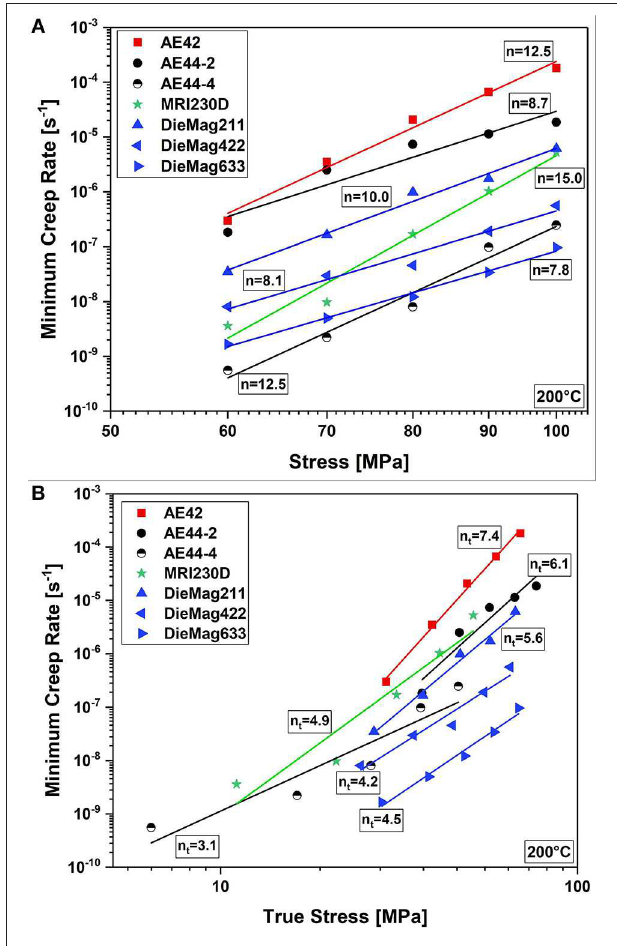
FIGURE 2 | Minimum creep rate over (A) stress applied during creep tests at 200 ◦ C and (B) true stress calculated with concept of threshold stresses at 200 ◦